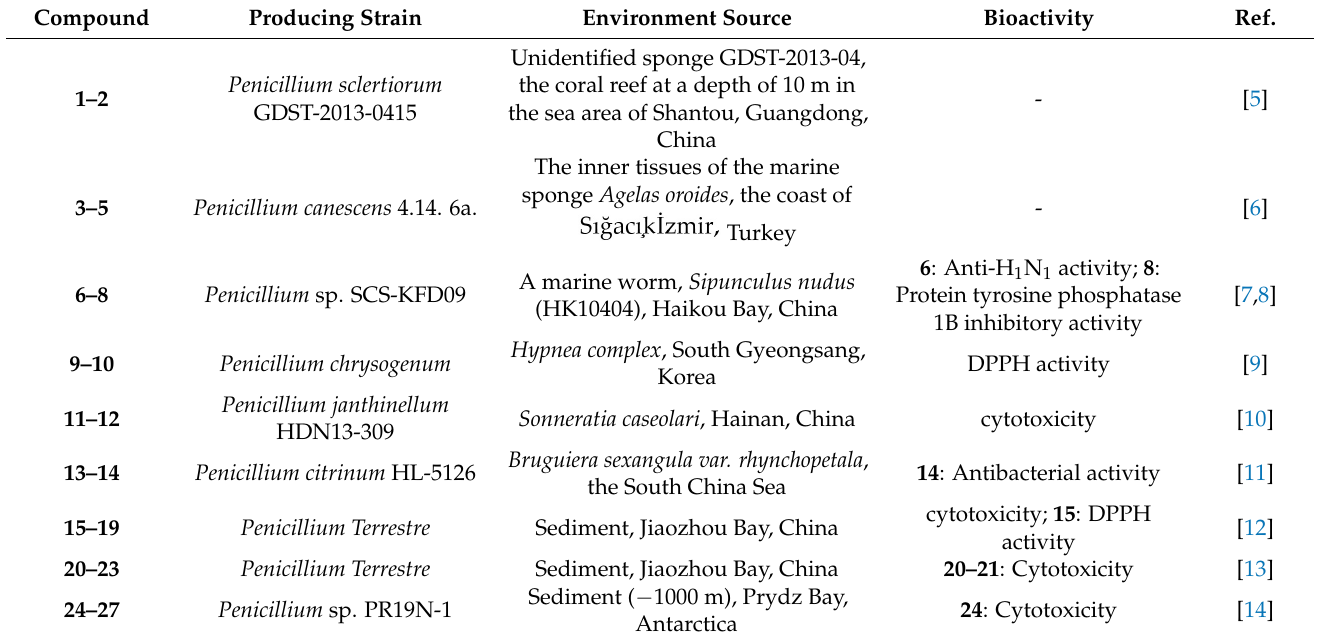
Table 2. Halogenated compounds isolated from marine fungi